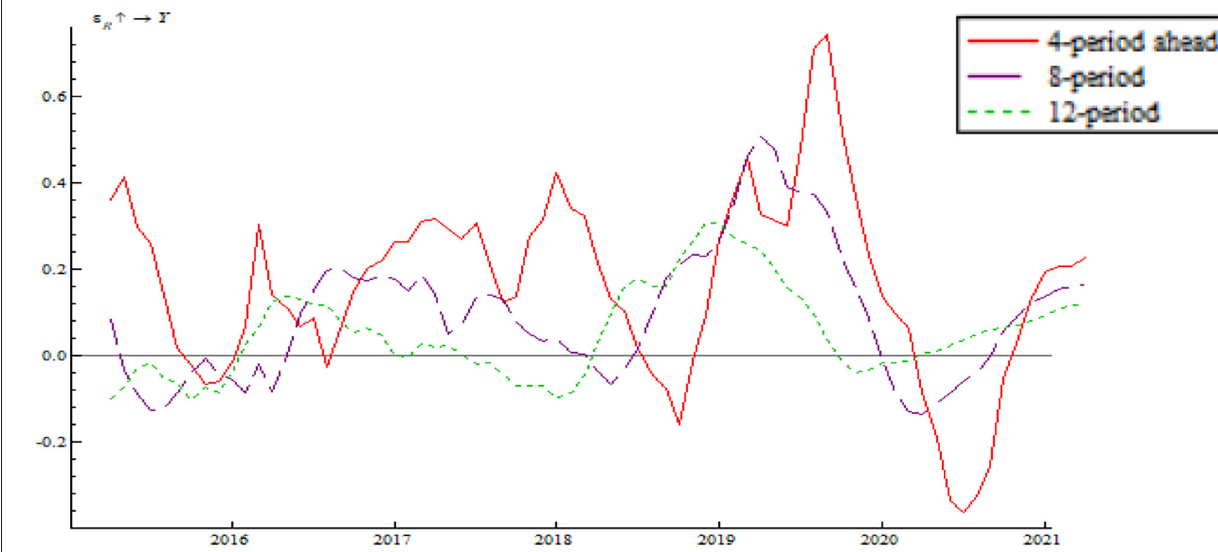
FIGURE 10 | Shock of price-based monetary policy on output gap.